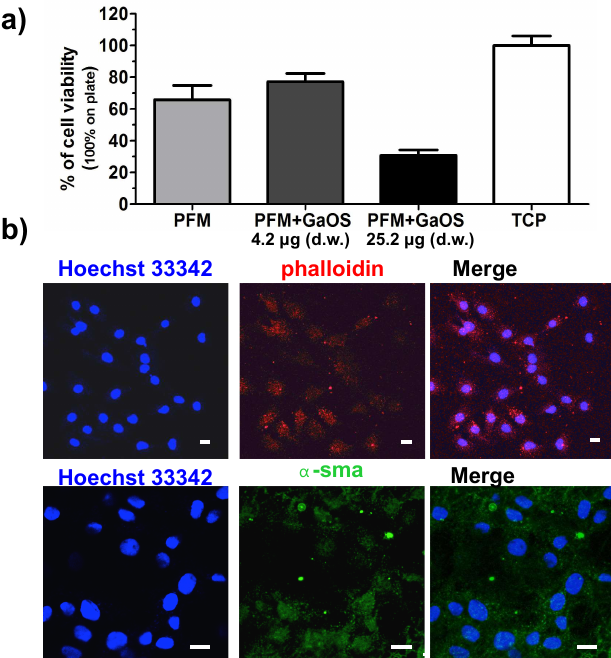
Figure 4. PFM+GaOS as scaffolds for cMSC cultures. ( a ) Cell viability of cMSC seeded on PFM disks (0.5 cm of diameter) with 0 μg, 4.2 μg (d.w.) and 25.2 μg (d.w.) of GaOS after 3 days of growth; ( b ) fluorescence confocal micrographs of cMSC cultured on PFM+GaOS with 4.2 μg (d.w.) of GaOS for 3 days. The nuclei are stained with Hoeschst 33342 (in blue) and the expressions of α-sma (in green) and phalloidin (in red) proteins are detected. Scale bars = 10 μm.